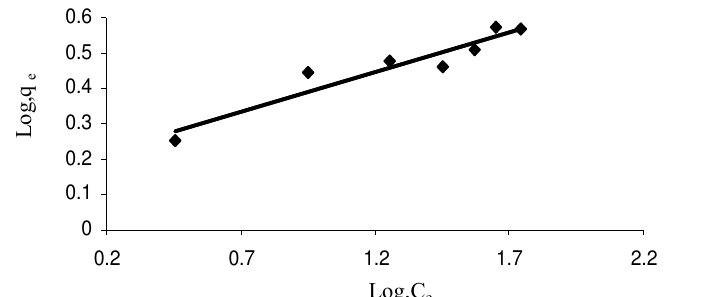
Figure 6. Langmuir isotherm model for present system (V=200 mL, Adsorbent dosage=0.8 g, pH=7, T=20 0 C, Contact time=3 day).